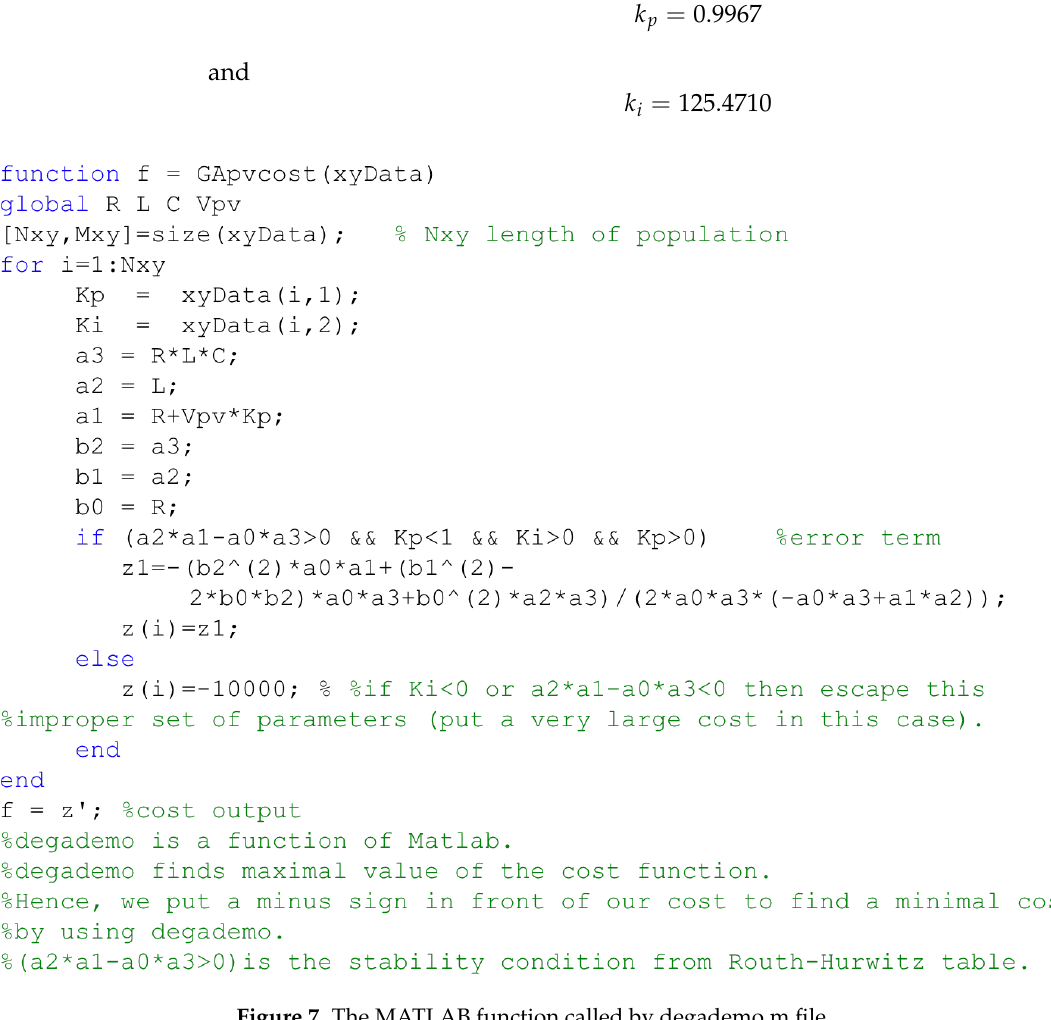
Figure 7. The MATLAB function called by degademo.m file.